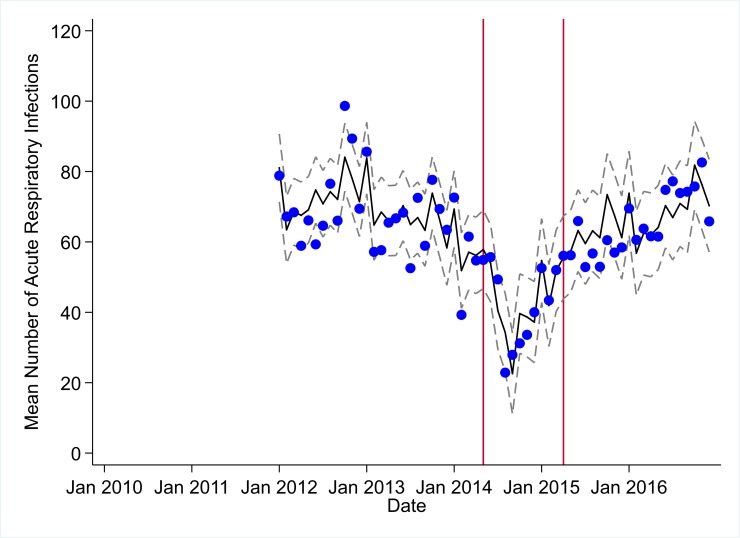
Mean trends and system losses due to Ebola virus disease (EVD) outbreak (June 2014–April 2015) for acute respiratory infections treated in a census of 379 clinics providing services in Liberia from 2010–2016, excluding Montserrado County.The black solid line represents the fitted mean from a linear mixed model using a segmented regression parameterization, random intercepts and slopes by facility, monthly indicator variables to adjust for seasonality, a fixed effect to adjust for clinic-level catchment area, and an AR(1) structure to account for autocorrelation in residual errors. Gray dashed lines are 95% confidence intervals around the fitted mean. Red lines are placed at the final month before the start (May 2014) and end (April 2015) of the EVD outbreak in Liberia.